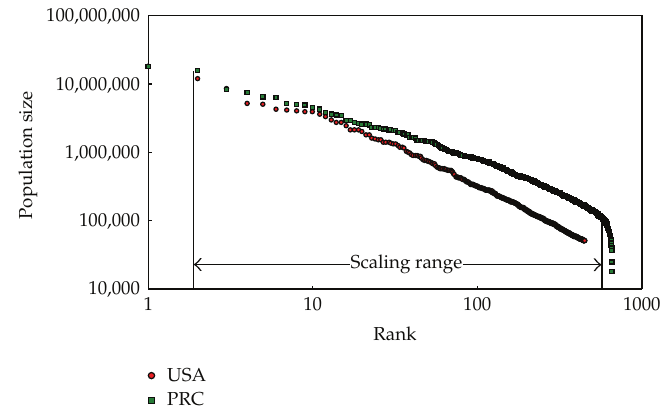
Figure 6: The rank-size patterns of the US cities in 2000 and the PRC cities in